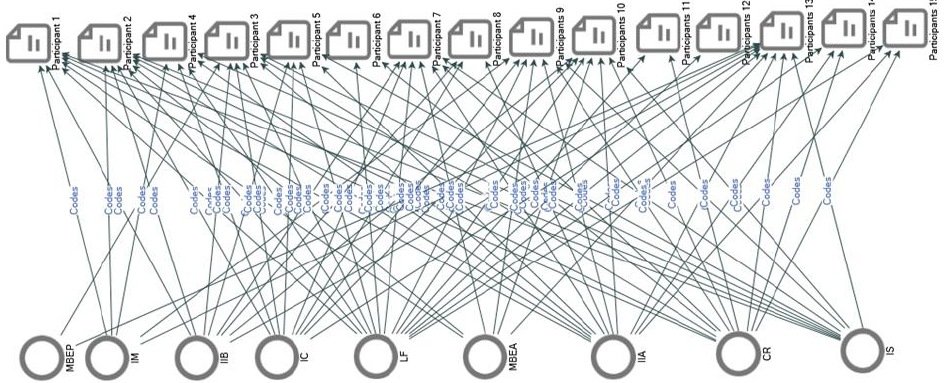
Figure 3. Coding in-depth interviews of 15 participants based on MLQ framework.